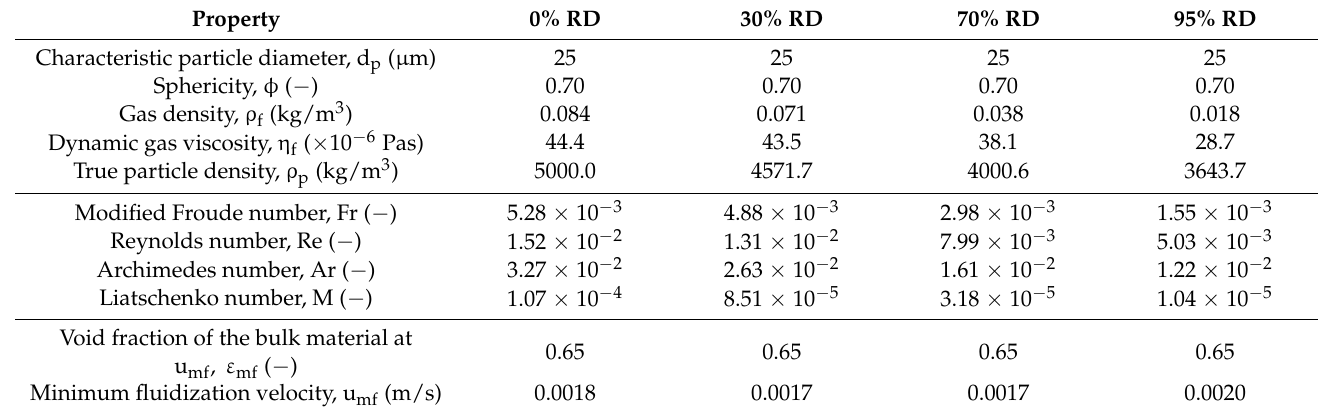
Table A2. Changing gas and bed material properties, dimensionless numbers, and minimum flu- idization velocity for reduction at 1173 K.